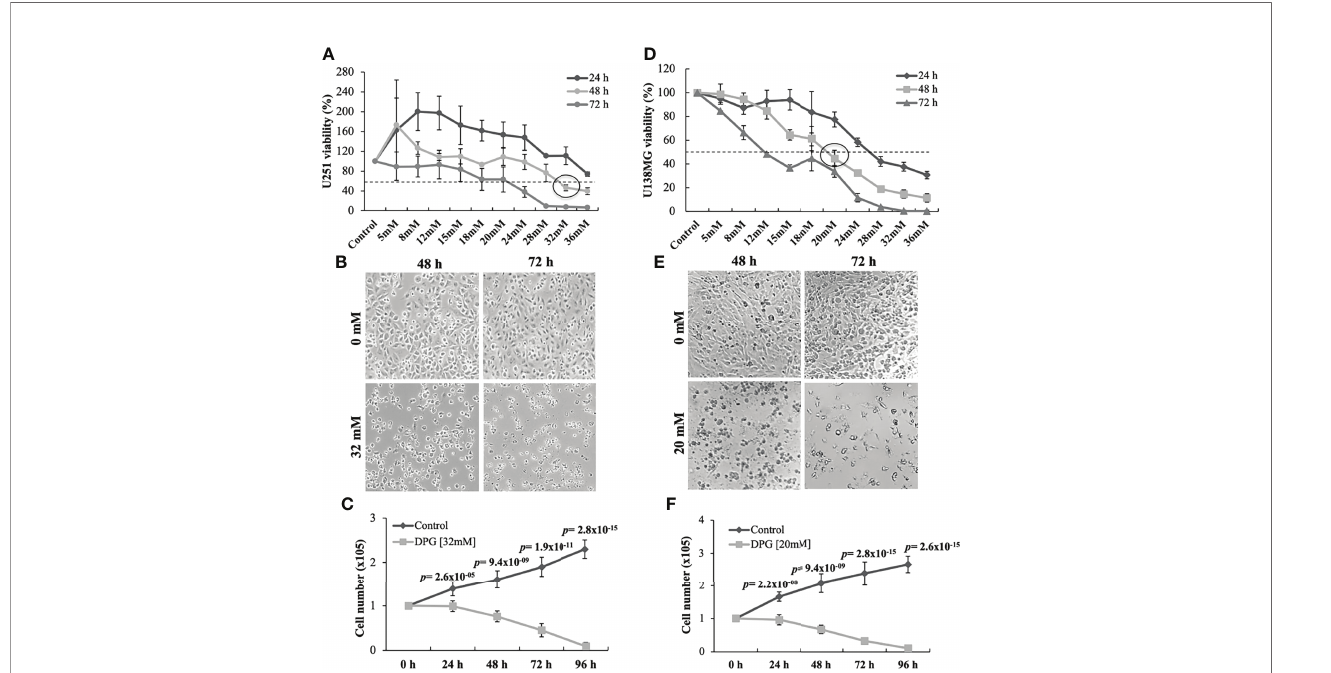
FIGURE 1 | Dipotassium glycyrrhizinate (DPG) reduces cell viability and changes morphology in glioblastoma cell lines. (A) U251 cells were treated with different concentrations of DPG for 24, 48, and 72 h and evaluated by the 4,5-dimethylthiazol-2-yl)-2,5-diphenyl tetrazolium bromide (MTT) assay to determine the IC50 (32 mM for 48 h). (B) Morphological and nuclear changes were observed in U251 cells, especially after 72 h of exposure to DPG, when compared to untreated cells. (C) The DPG treatment also signi fi cantly inhibited the rate of proliferation in U251 cells in a time-dependent way compared to untreated cells. (D) U251 cells were treated with different concentrations of DPG for 24, 48, and 72 h and evaluated by the MTT assay to determine the IC50 (20 mM for 48 h). (E) Morphological and nuclear changes were observed in U138MG cells, especially after 72 h of exposure to DPG, when compared to untreated cells. (F) The DPG treatment signi fi cantly inhibited the rate of proliferation in U138MG cells in a time-dependent way compared to untreated cells. The data presented are the mean ± standard deviation of the experiments performed in triplicate. The T -test indicated p -values ≤